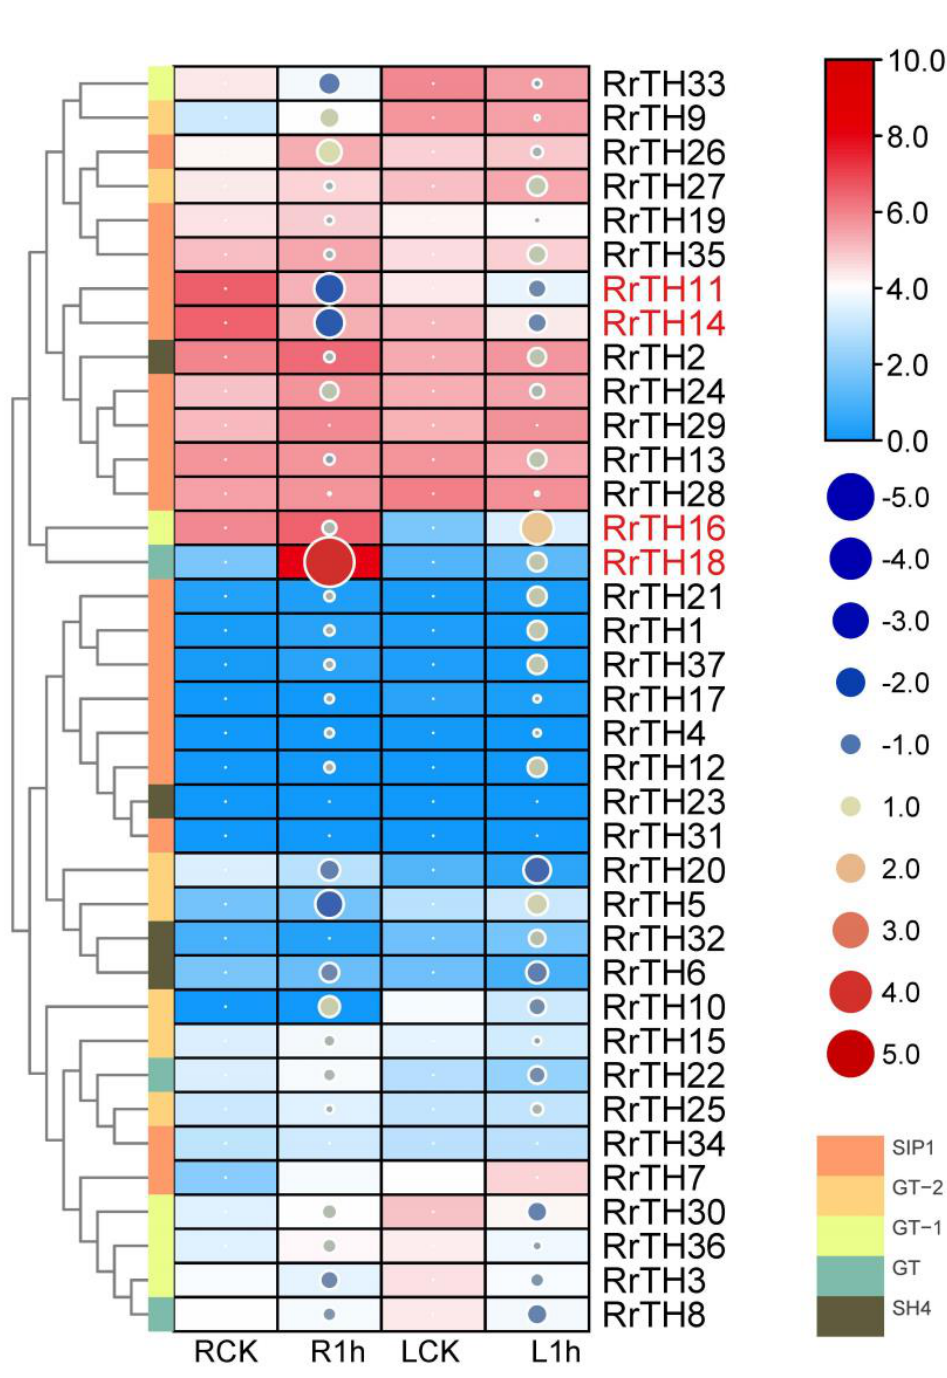
Figure 4. Expression profiles of RrGTs under salt stress in roots and leaves of R. rugosa . Four columns indicated roots or leaves of R. rugosa seedings treated by NaCl solution (R1h or L1h) and water (RCK or LCK) for 1 h. Normalized FPKM (per kilobase of exon model per million mapped fragments) (Table S2) are indicated by the boxes with gradient colors. Log2(fold-change) (Table S2) using RCK and LCK as controls were indicated by size and gradient color of circles. Rows were clustered by hierarchical clustering of Euclidean distance. Five lineages were represented by colored nodes of clustergram. Differentially expressed RrGTs were labeled in red. –